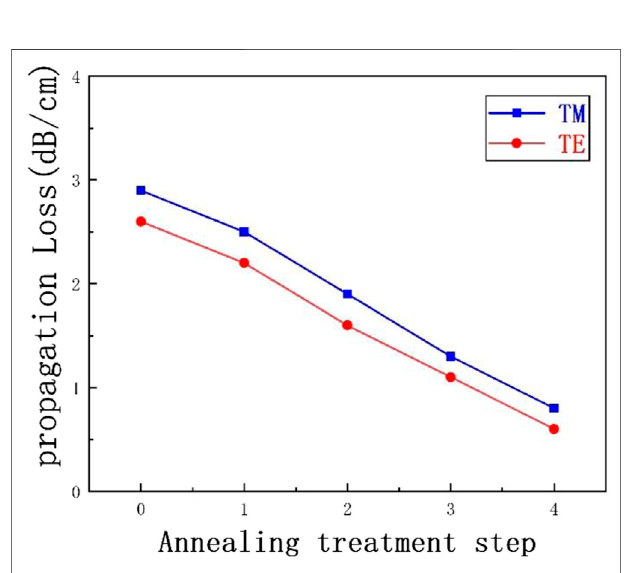
FIGURE 6 | Raman spectra of 1.2 GeV Kr 8+ ion irradiated ZnS crystal in waveguide region (blue line) and substrate region (red